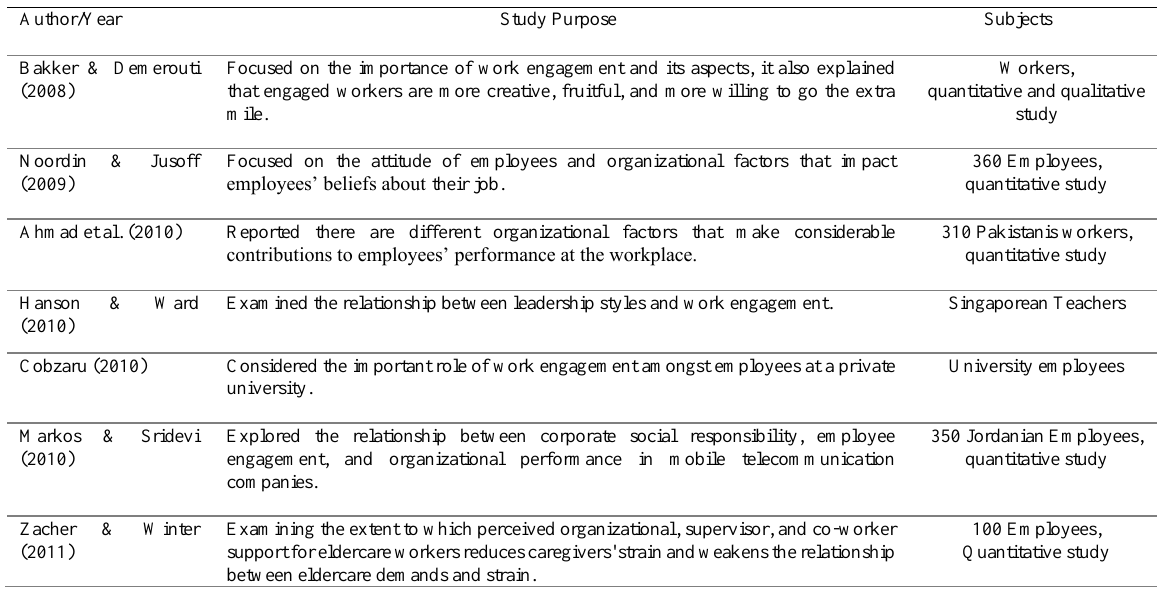
Table 1: Summary of Researchers’